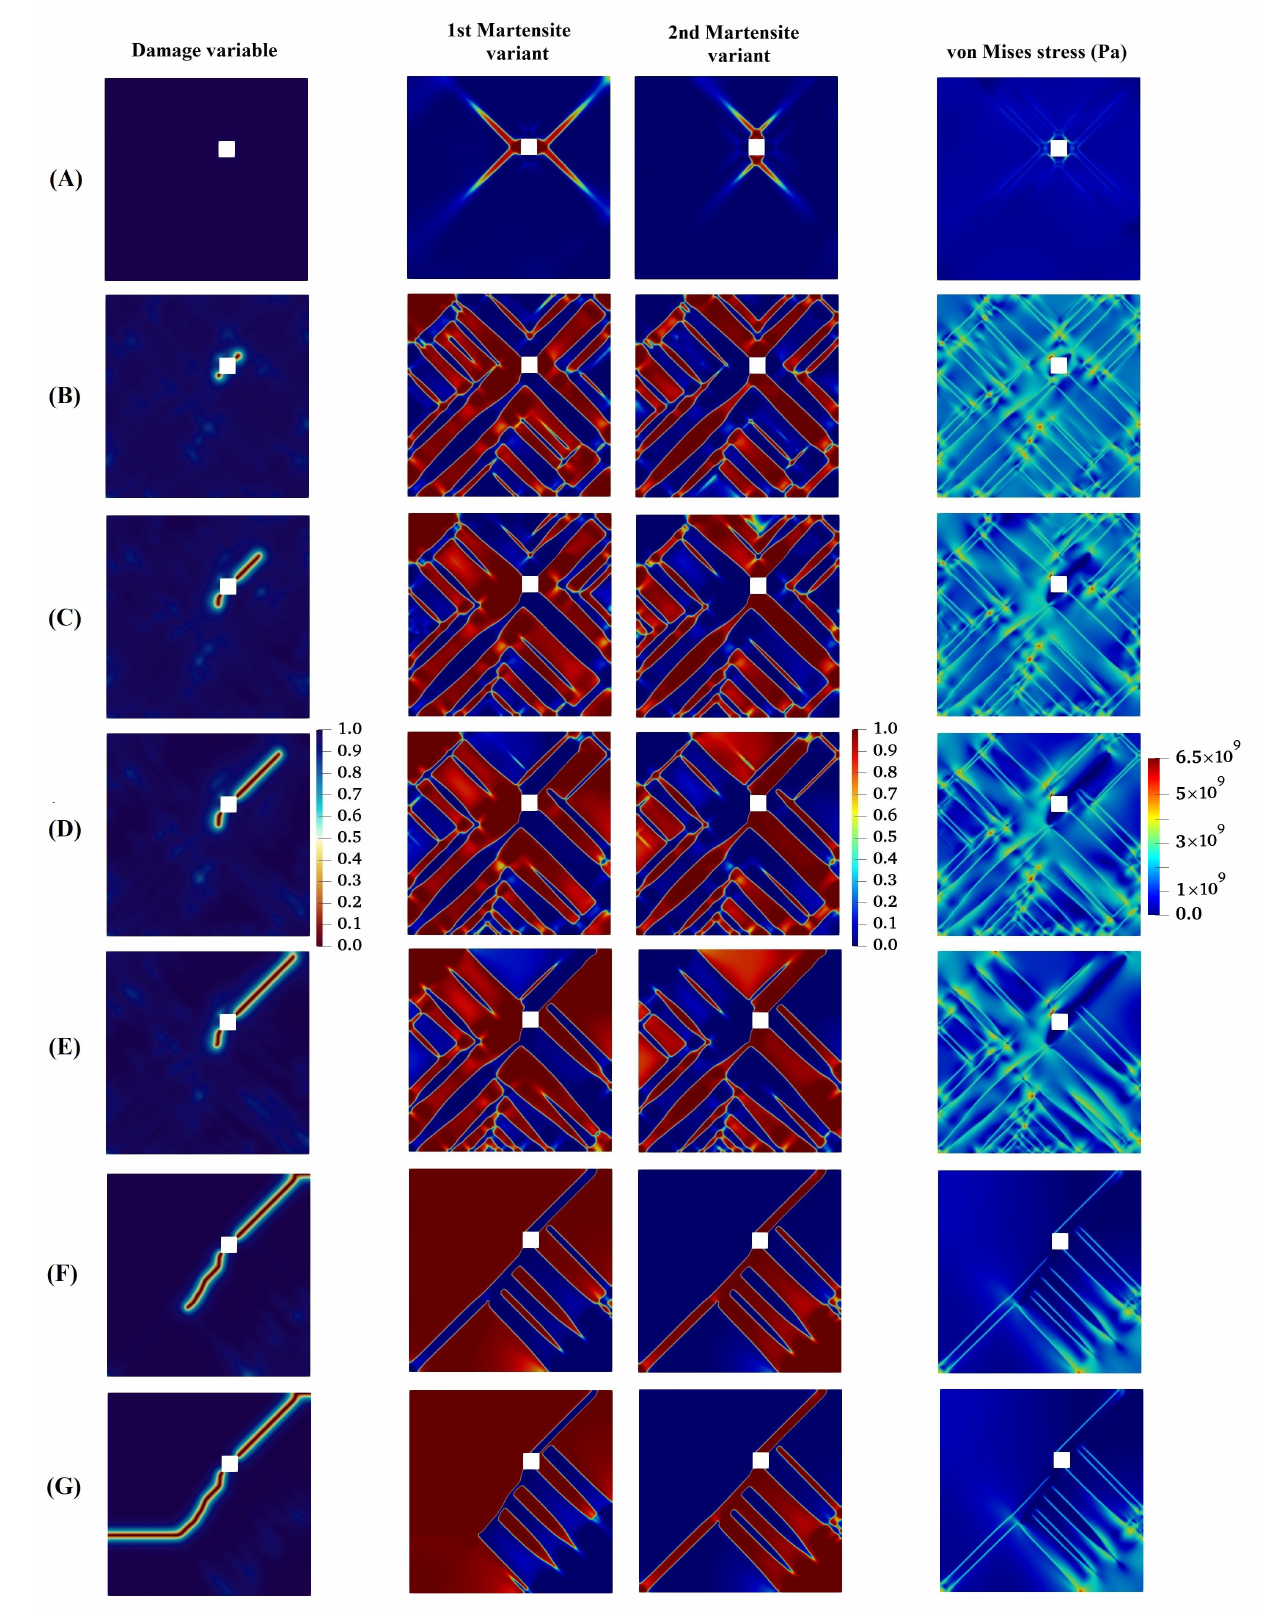
Figure 12. Evolution of damage variable, two martensite variants, and von Mises stress in the austenitic microstructure with a geometric